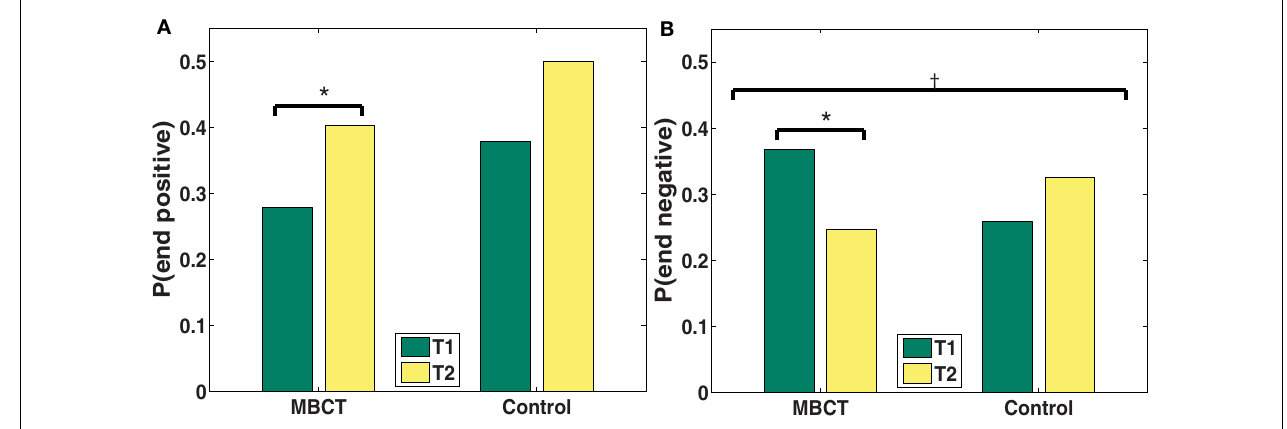
FIGURE 4 | (A,B) Changes in probability of stopping fromT1 toT2 by valence category ( A : positive; B : negative). * p < 0.05, † p < 0.1.